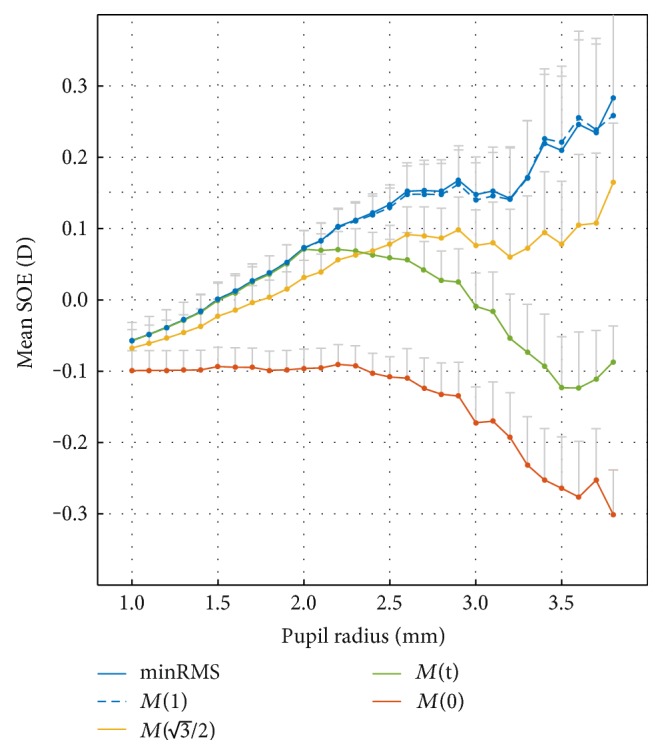
Mean SOE in function of the pupil radius for all 308 subjects of the AHM dataset, and for t = 0, 1, 3/2, t(r), and additionally, the minRMS metric. The error bars represent +1 SEM.